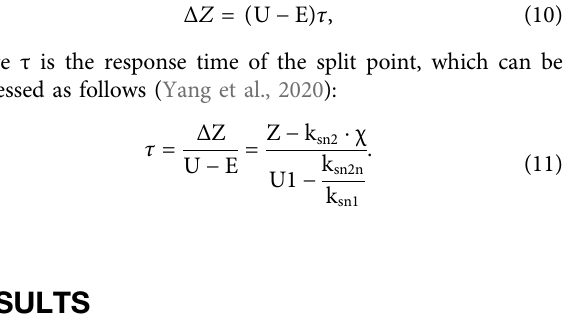
Frontiers in Earth Science |